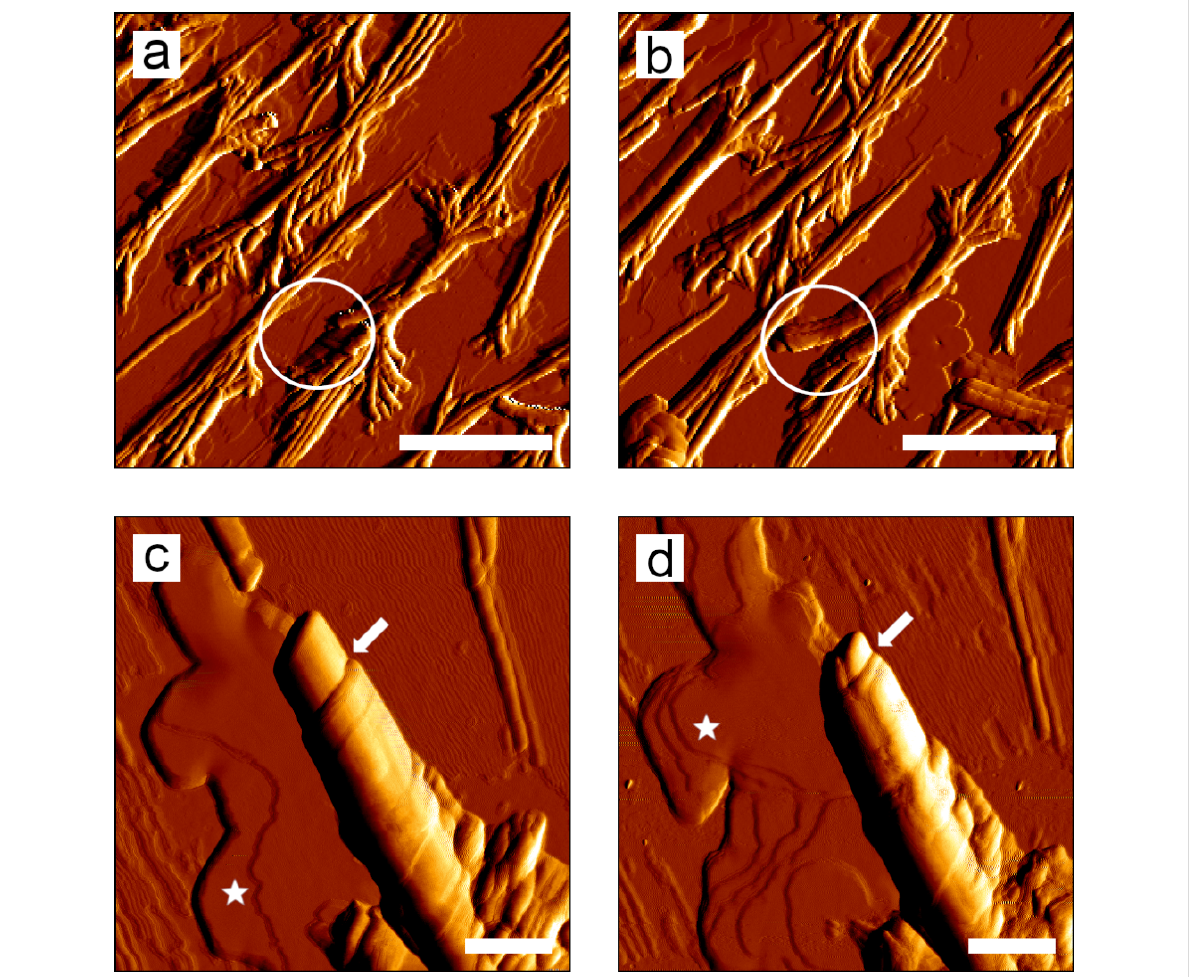
Figure 8: AFM images of recrystallized tubules of a ß-diketone solution on glass. (a,b) Flat-growing branched tubules ordered as traces in the same position (a) 50 min and (b) 4 h and 45 min after the application of the ß-diketone solution. White circles indicate length increase of a tubule and white arrows show an expanding layer close to the tubules. (c,d) Detailed view of a tubule tip with the edge of a layer on its surface (white arrows) and layers with several steps (white stars); (c) 6 h and 8 min and (d) same position, 6 h and 22 min after the application of the ß-diketone solution. Scale bars in (a,b) 2 µm, in (c,d) 500